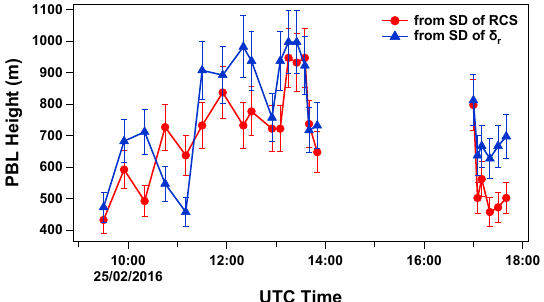
Figure 3 Time evolution of the PBL height (with the corresponding standard errors of the mean) retrieved from the RCS (red dots) and  r lidar signals (blue triangles).